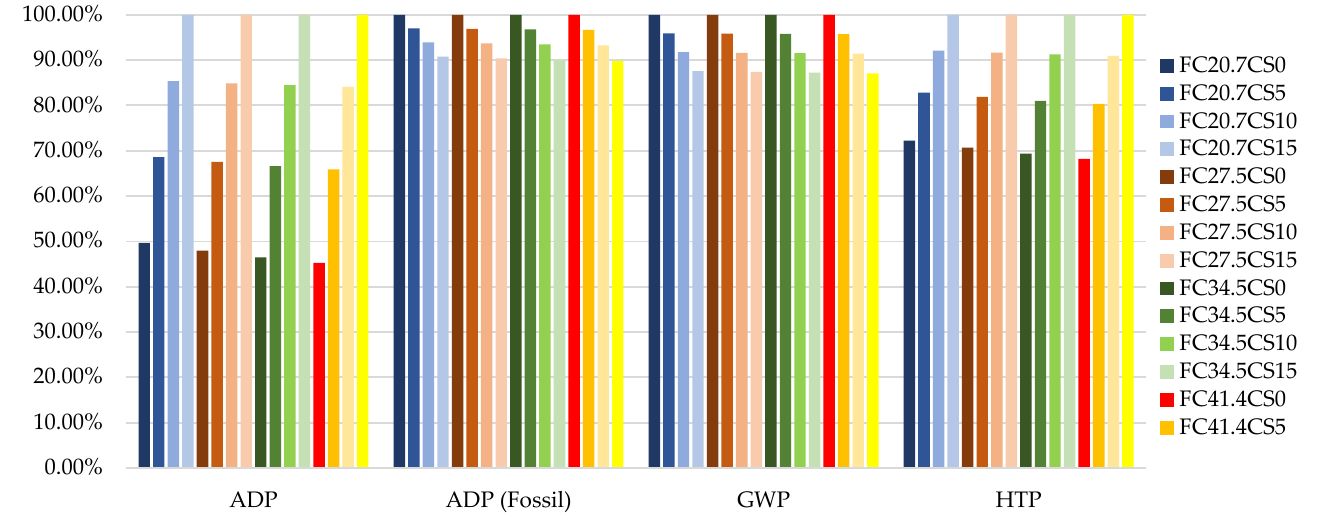
Figure 8. Seven-story building environmental impact assessment.